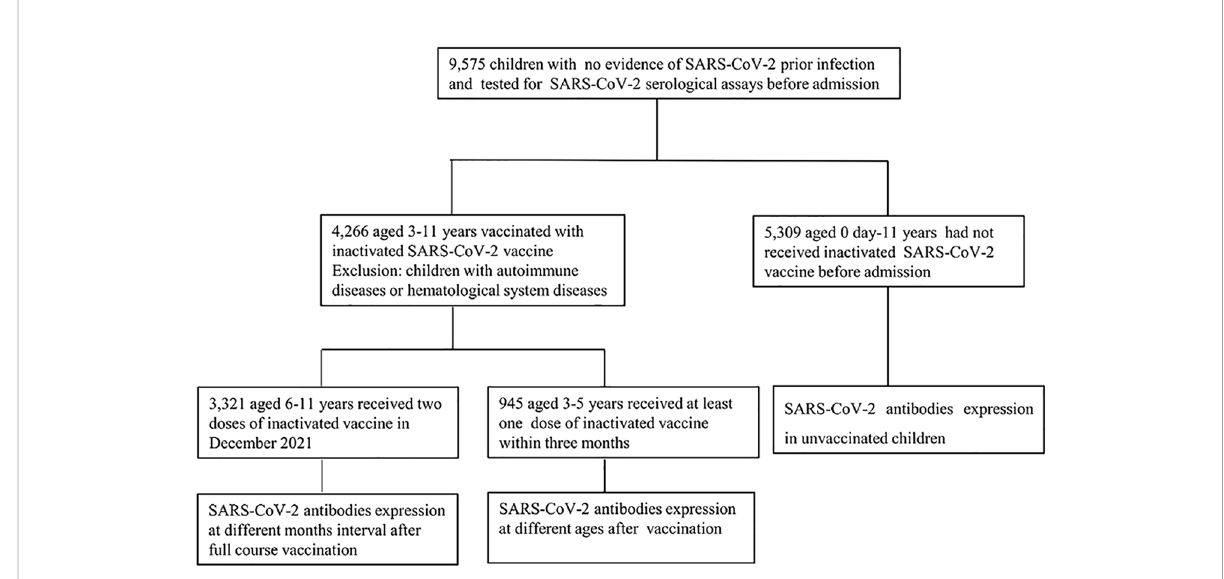
TABLE 1 Gender and age distributions of children who were tested for SARS-CoV-2 IgM and IgG antibodies. Group Age Post vaccination (months or age) Number of cases Gender Vaccinated with 2